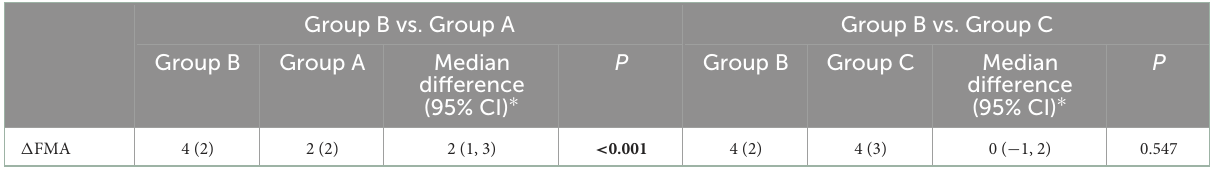
TABLE 5 Comparison of MBI scores before and after treatment among the three groups. Group T0 (MBI) ∗ T1 (MBI) ∗ 1 MBI ∗ P A B